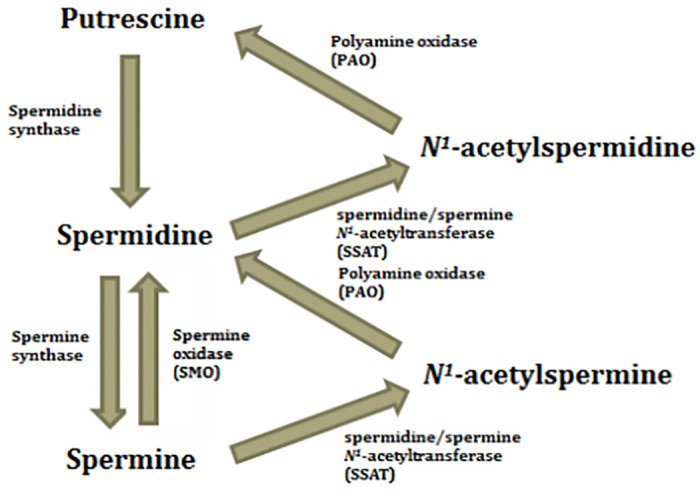
Polyamine metabolic pathway (focusing on Put, Spd and Spm only).